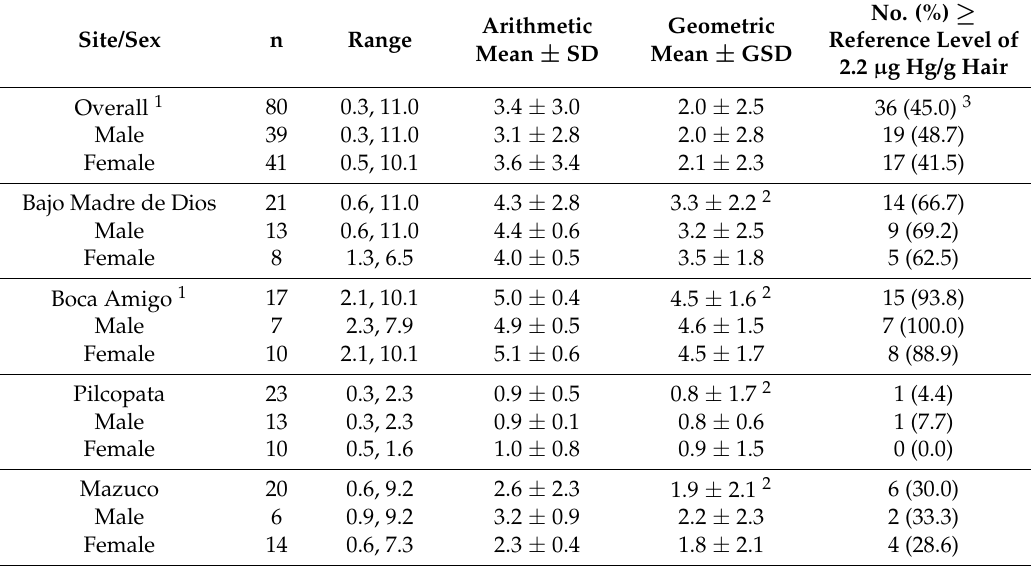
Table 4. Descriptive statistics for the mercury ( µ g Hg/g hair) in human hair samples by site and sex, at four study sites in the Madre de Dios river basin of Southeastern